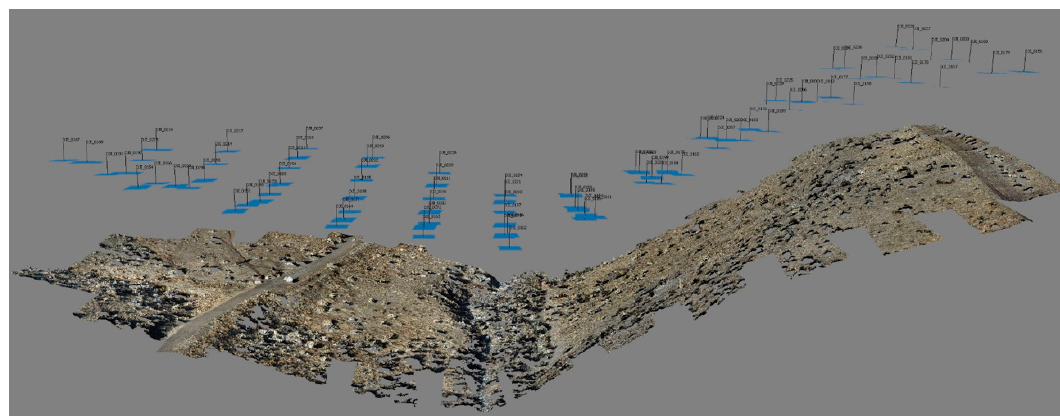
Figure 9. Generated point cloud and position of images captured during Stage 2 flight.